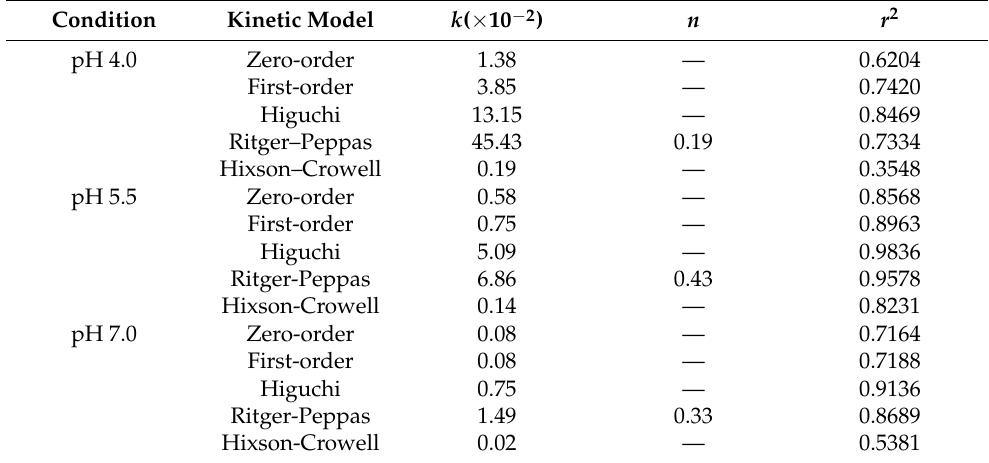
Table 2. Determined parameters of KSM released from ZIF-90-KSM by fitting several kinetic equations.